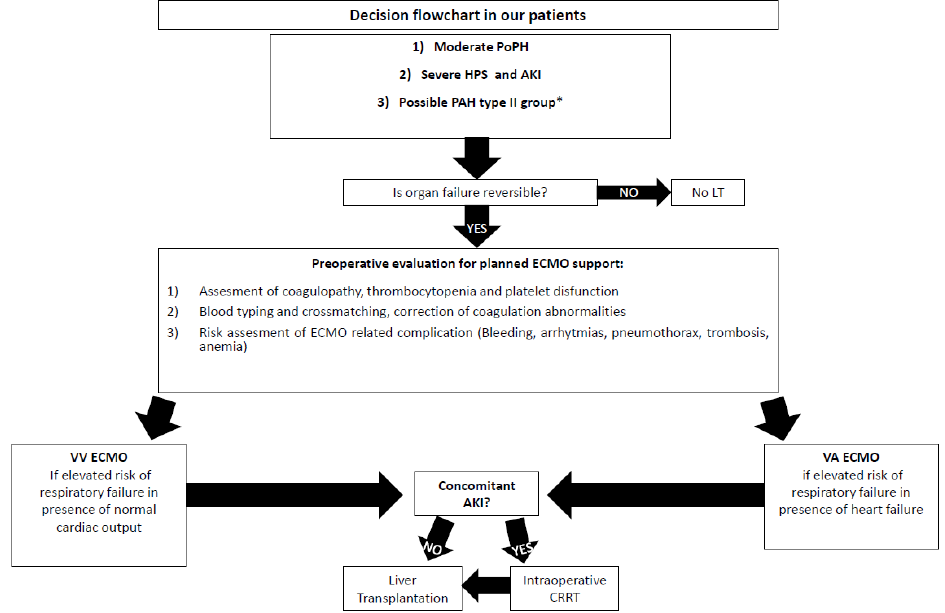
Figure 2. Decision Flowchart in our cases. * WHO Group 2 encloses PAH due to left heart disease.